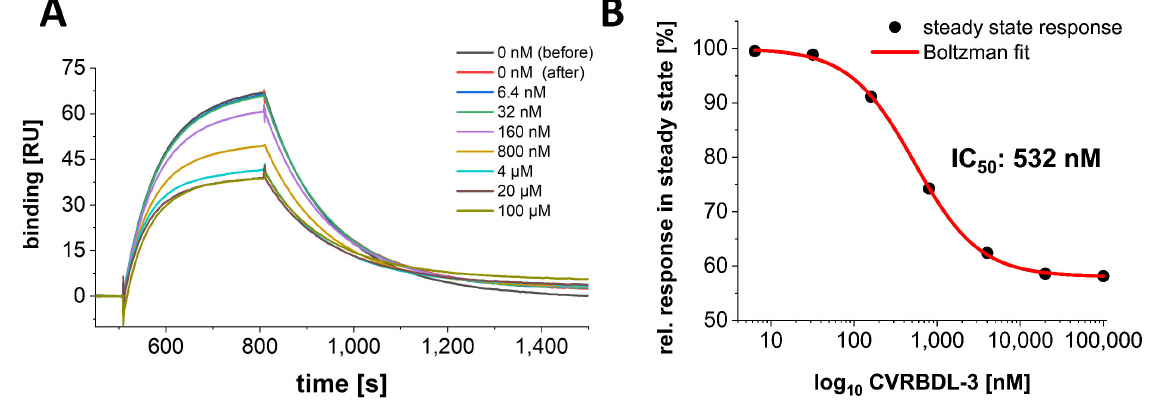
Figure 6. Concentration dependency of the inhibitory effect of CVRBDL ‐ 3 on the SARS ‐ CoV ‐ 2 S1S2 interaction with hACE2. ( A ) hACE2-fc was immobilized on a protein A/G derivatized sensor surface in a T200 SPR device (Cytiva, USA). 50 nM SARS-CoV-2 S1S2 was injected with or without 6.4 nM to 100 µ M CVRBDL-3. Injections without compound were performed prior and after the concentration row to demonstrate reproducibility of the S1S2 binding level. All injections with compound were referenced with the corresponding concentration of compound only injections on the hACE2 immobilized surface. Injections were performed with a flow rate of 30 µ L/min in 10 mM HEPES pH 7.4, 150 mM NaCl, 3 mM EDTA, 0.005% ( v / v ) Tween-20. ( B ) Relative response in steady as detected at t = 750 s. The inhibitory effect of CVRBDL-3 saturates at ~58% of the S1S2 binding level without compound. The IC 50 was determined by a Boltzman sigmoidal fit to be 532 nM (OriginPro, OriginLab,